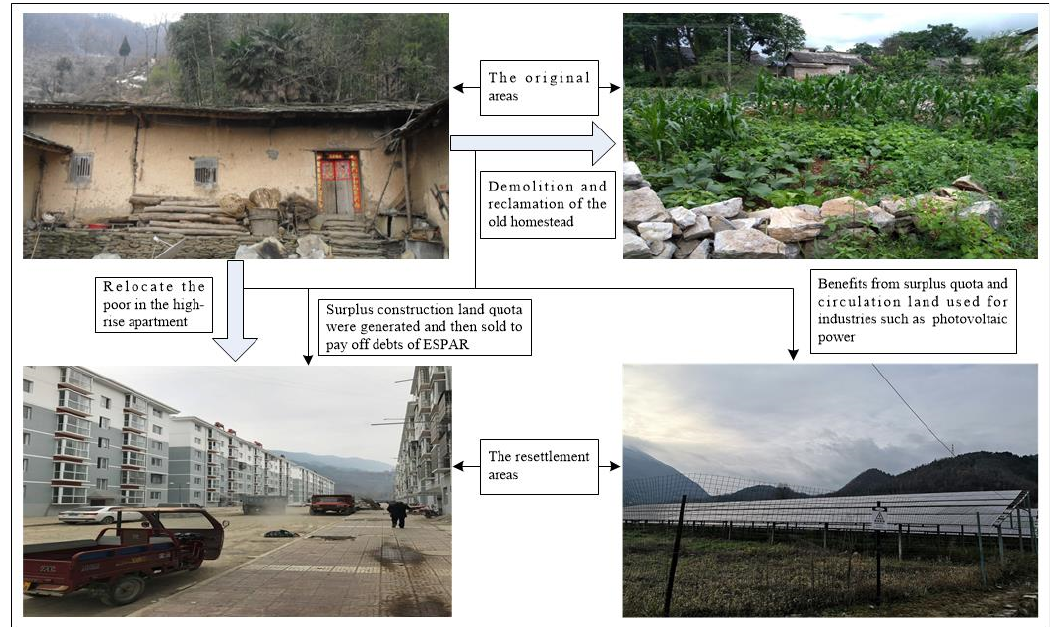
Figure 1. Depiction of how the demolition of homesteads can make land available for other purposes. Note: Photos taken by Peng Shi in 2012 and 2018.